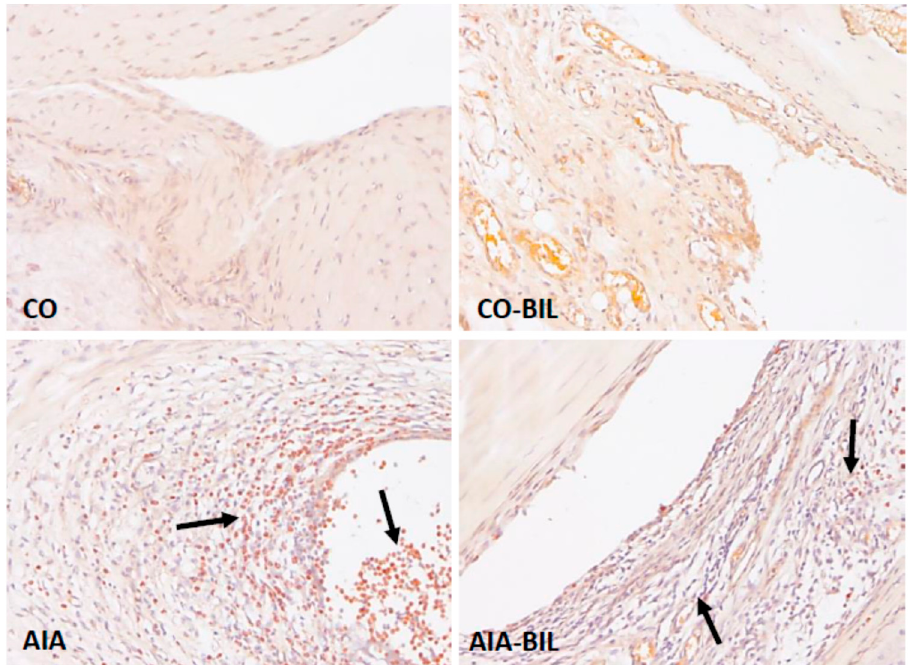
Figure 5. Infiltration of joints by granulocytes detected with naphtol ‐ AS ‐ D ‐ chloroacetate esterase (CHAE) activity. Dense granulocytic infiltrate (arrow) in the inflamed joints (AIA) was reduced by UCB treatment (AIA ‐ BIL). CO—control group, CO ‐ BIL—control group administered with UCB 200 mg/kg of body weight daily i.p. from day 14, AIA—group with adjuvant induced arthritis, AIA ‐ BIL—group with adjuvant induced arthritis administered with UCB 200 mg/kg of body weight daily i.p. from day 14. CHAE, 100×.